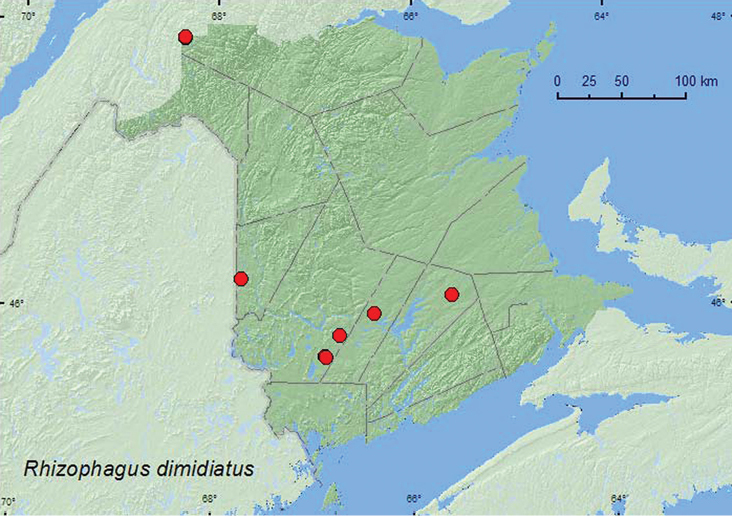
Collection localities in New Brunswick, Canada of Rhizophagus dimidiatus.